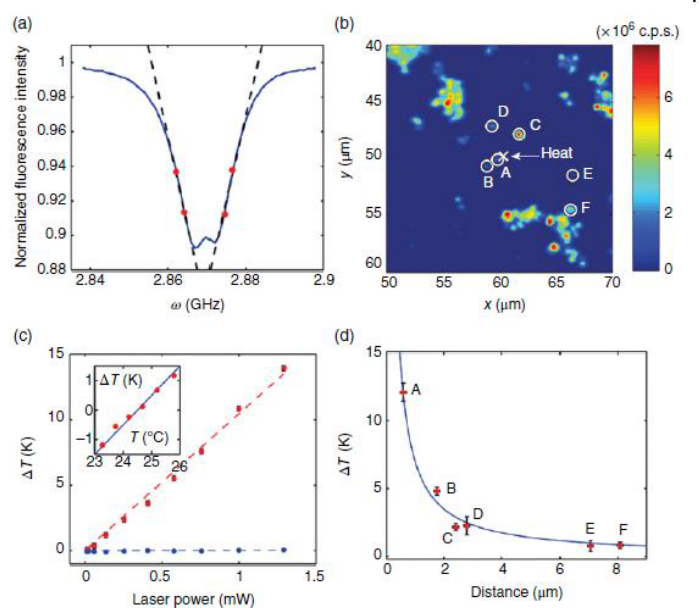
Figure 16. ( a ) ODMR spectrum around the NV center of a single ND. The four red points indicate the RF frequencies used to extract the temperature (maximum slope of the dip). ( b ) Confocal spatial map of fluorescent NDs (circles) and gold nanoparticles (cross). ( c ) Temperature of a single ND as a function of laser power with (red) or without (blue) laser illumination on a nearby gold nanoparticle. ( d ) Temperature changes of a single ND, as a function of the distance from the illuminated gold nanoparticle indicated by the cross. Reprinted with permission from [102], Springer, 2013.